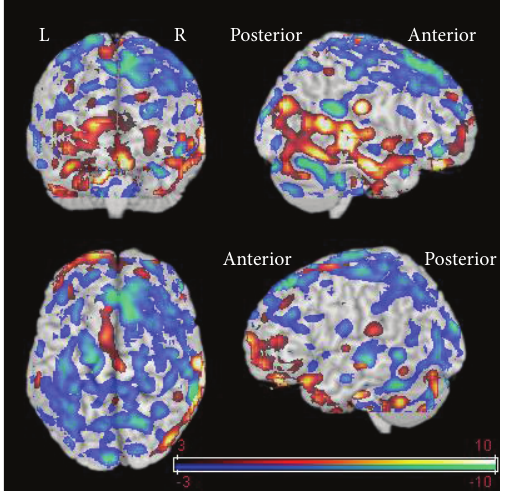
Figure 2: Cortical surfaces with post hoc 𝑡 values greater than +3 (in red and yellow) or − 3 (in blue and green) as calculated by SPM5 usingtheBOLDcontrast(jhana-rest).Notethattransitiontojhanais associated with selective increases in BOLD signal in right temporal region and with decreases in parietal lobe and posterior frontal